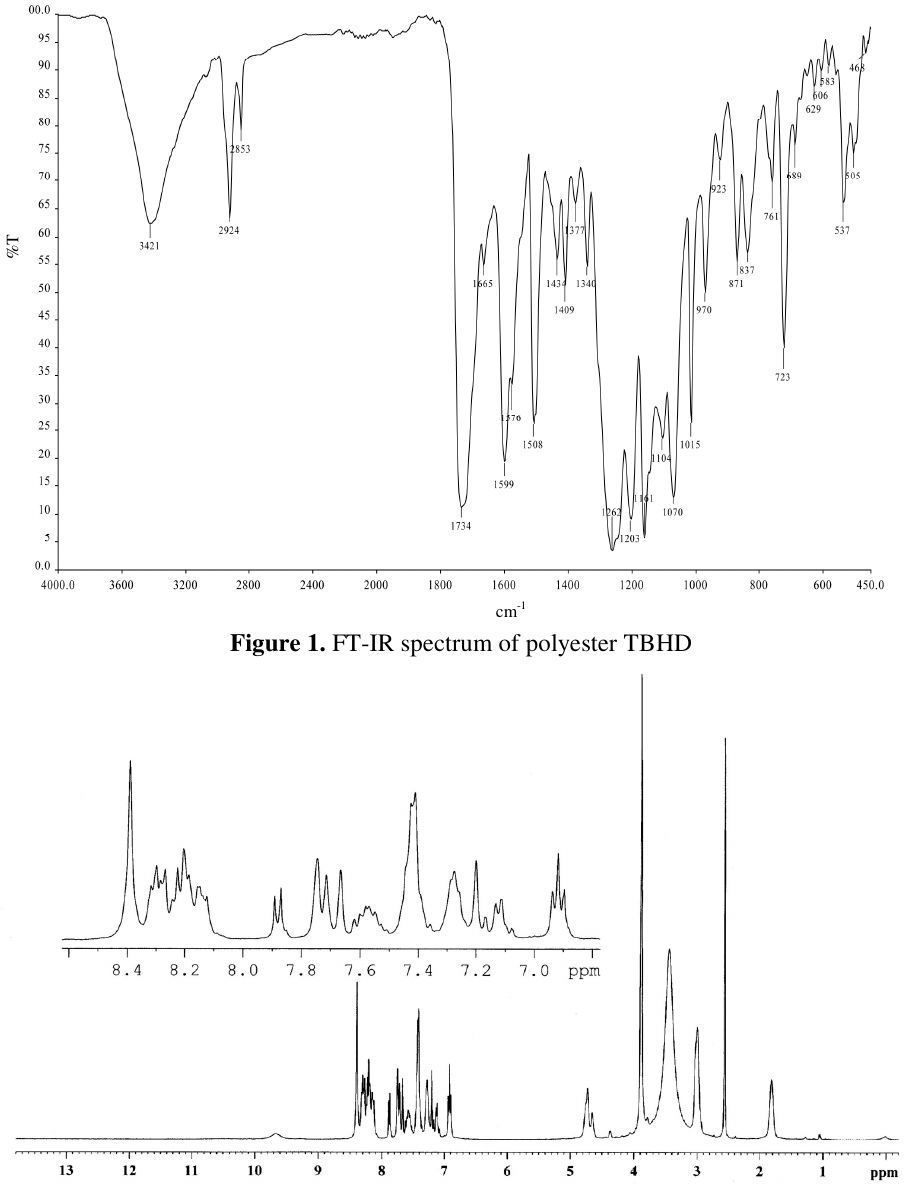
Figure 2. The vanillylidene aromatic protons appeared in the region 6.8 to 7.2 δ . The methoxy protons of the divanillylidene mesogen appeared as a singlet at 3.9 δ . The OCH protons connected to the benzoyl group of the common diol D appeared at 4.7 δ . The multiplets in the range of 7.4 to 8.4 δ referred to benzoyl aromatic protons. The protons of cyclohexanone appeared at 1.8 at 2.9 δ .